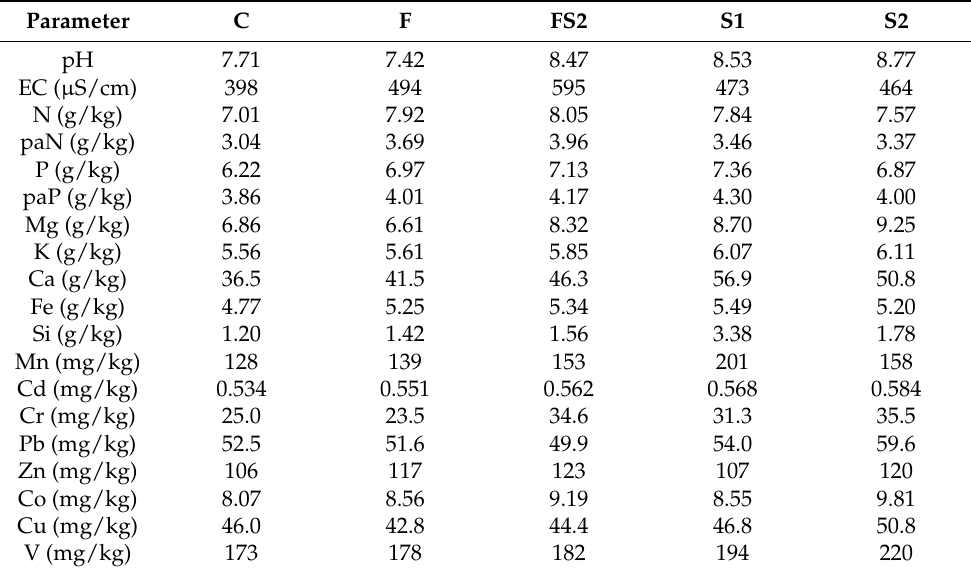
Table 1. Physico-chemical analysis of: control soil (C–without EAF slag or NPK fertilizer), soil enriched with synthetic NPK fertilizer (F), soil enriched with a combination of 2% EAF slag and NPK fertilizer (FS2), and soil enriched with EAF slag (S1–at 1%, S2–at 2% level). Parameter C F pH